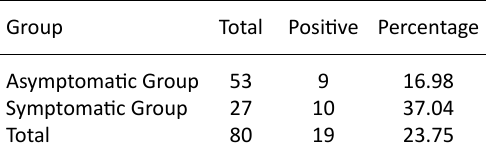
Table 1. Showing prevalence of Parasites in Asymptomatic and Symptomatic group